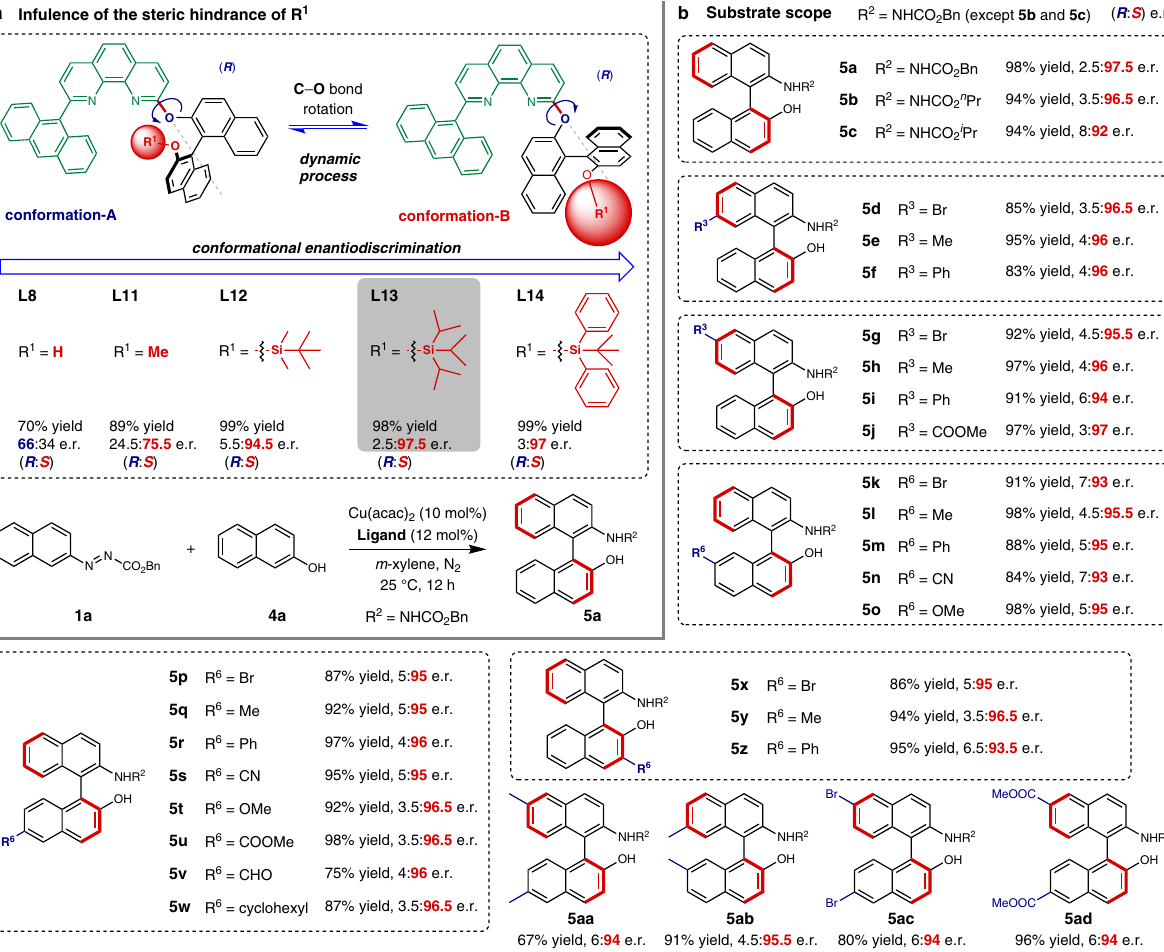
(2.0mL), under N 2 , at 25°C. All yields are isolated. Enantiomeric ratios (e.r.) were determined via HPLC analysis and reported as ( R : S ). Me, methyl; n Pr, n -propyl; i Pr, iso -propyl; Bn, benzyl; Ph, phenyl. The absolute con fi guration of all the products with red thick bonds is S